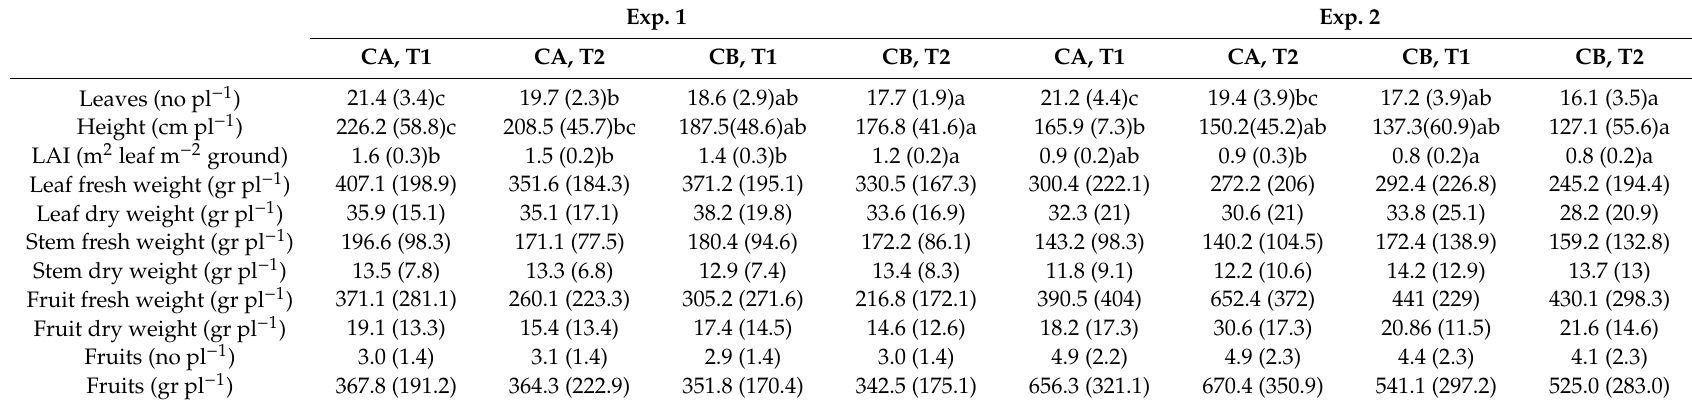
Table 2. Mean values ( ± standard deviation) of fresh and dry weight of leaves, stem, and fruits, leaf area index (LAI), leaves, height and number of fruits and weight per plant for (autumn–winter crop; Exp. 1) and (spring crop; Exp.